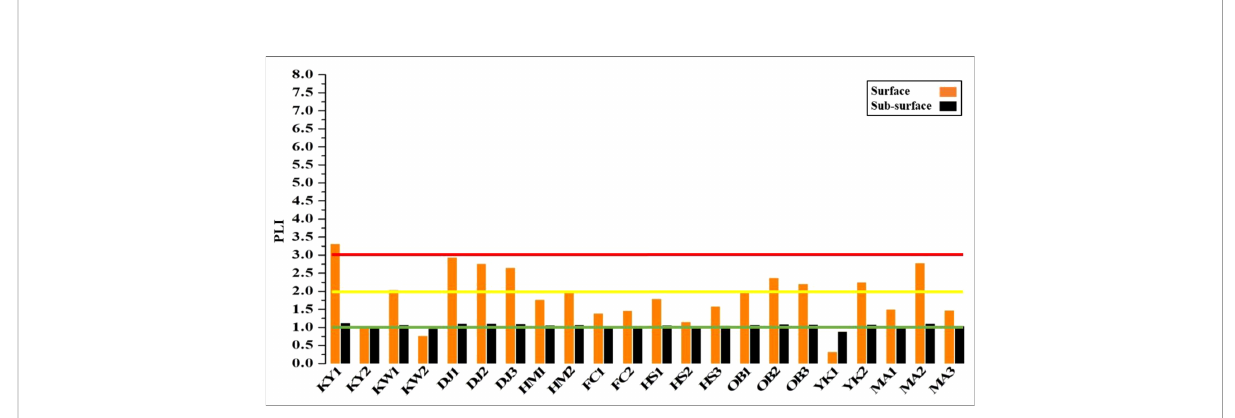
FIGURE 7 Pollution load index (PLI) with pollution degree for different studied sites in surface and sub-surface sediments of Siangshan wetland. Green, yellow, and red lines refer to classes 0, 1, and 2, respectively (Table